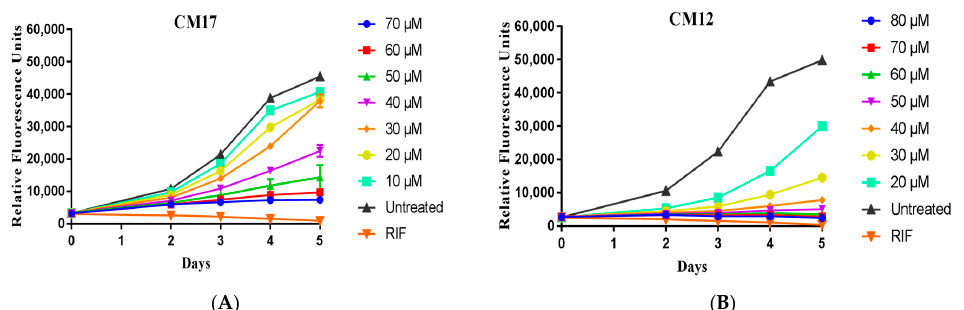
Figure 3. Mycobacterial growth inhibition by compounds CM12 ( A ) and CM17 ( B ) at narrower concentration intervals. M. tuberculosis H37Rv:pCHERRY3 was cultured in 96 well plates as described, with compounds at the concentrations as shown. Experiments were repeated in biological triplicates; each plot shown here shows a representative biological replicate with the mean and standard deviation of 3 technical replicates for each data point.